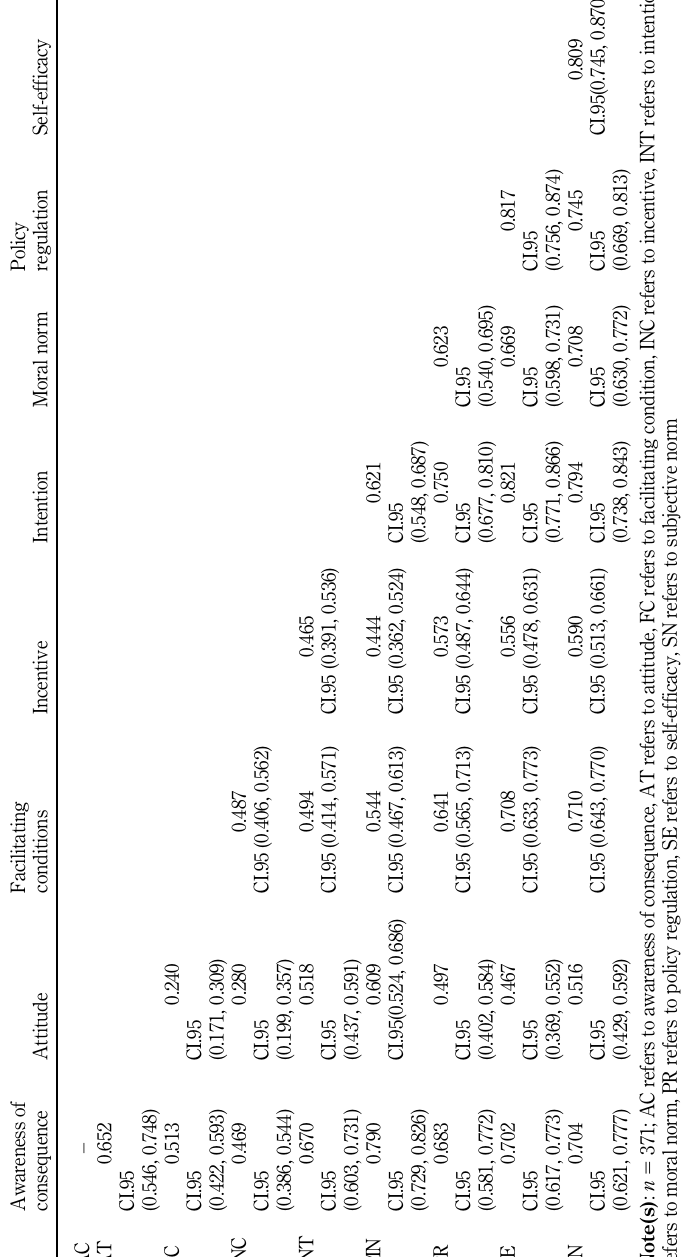
Table 4. Discriminant